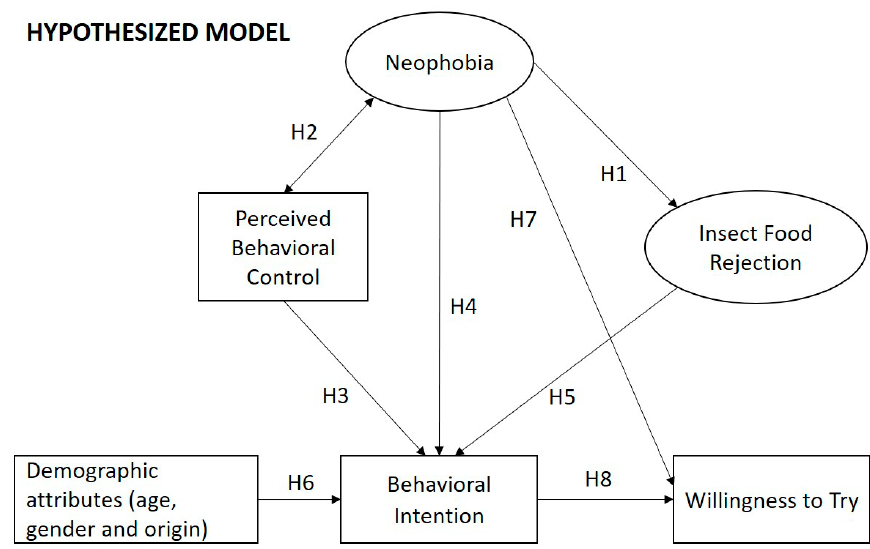
Figure 1. The conceptual model corresponding to the current research. Our study tested the following hypotheses (H): H1, food neophobia will positively affect rejection factors of insect as food (e.g., disgust) [10]; H2, food neophobia and the perceived behavioral control (PBC) will be correlated; H3, PBC will have a significant positive effect on the intention of eating an insect-based food in the